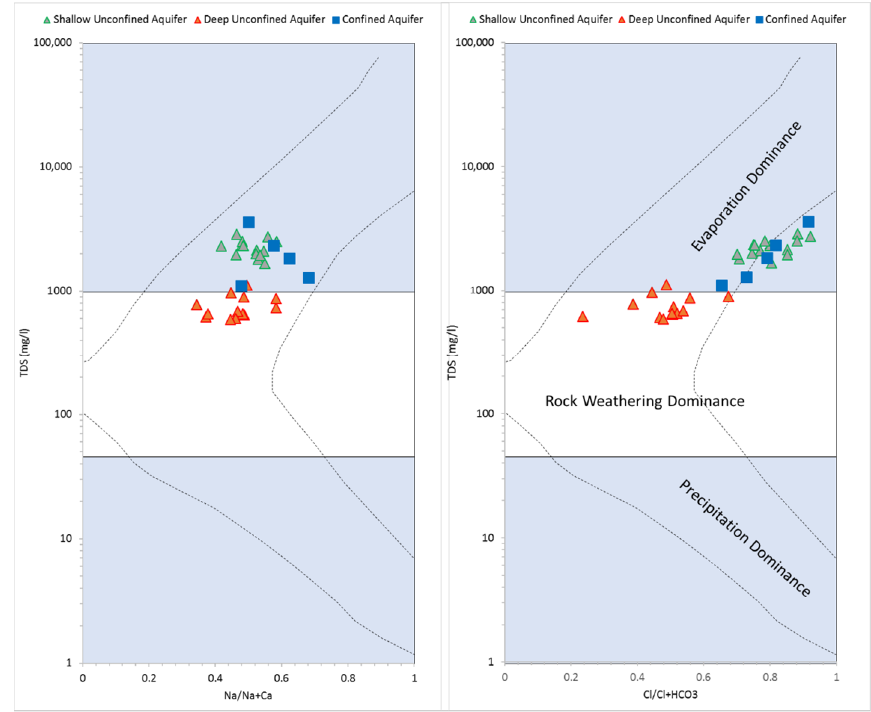
Figure 6. Gibbs diagram of the collected groundwater samples from Wajid aquifer.